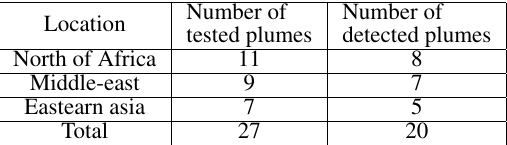
Table 1. Results of the method in several locations.